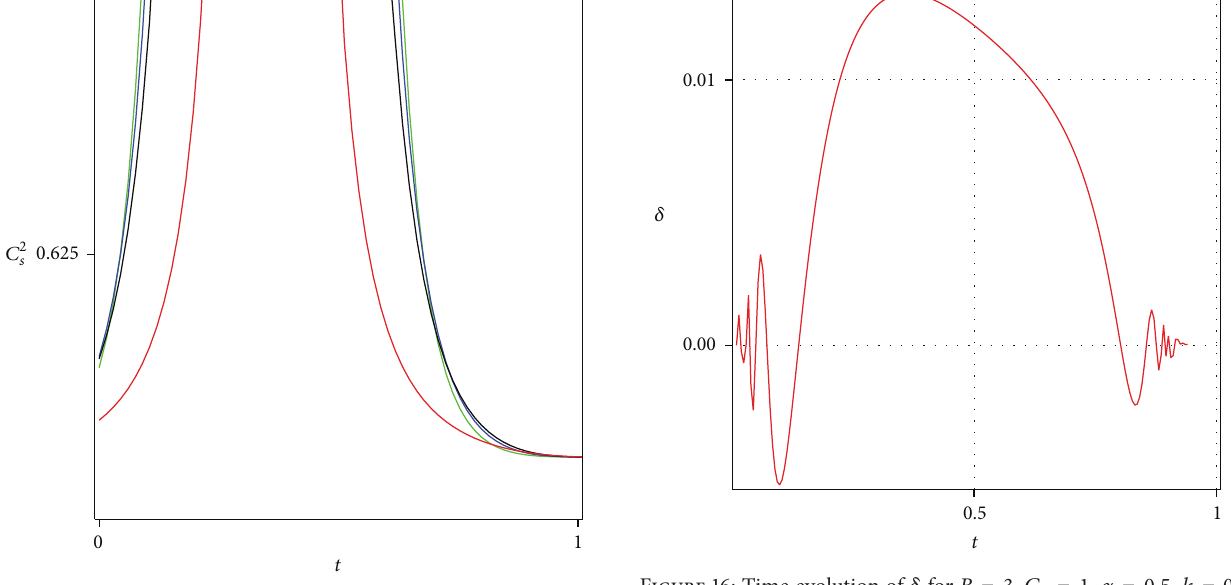
Figure 15: Squared sound speed for 𝐵 = 3 , 𝐶 2 = 1 , 𝑛 = 2 , and 𝐴 = 1/3 . 𝛼 = 1 (green line), 𝛼 = 0.7 (blue line), 𝛼 = 0.5 (black line), 𝛼 = 0.1 (red line).